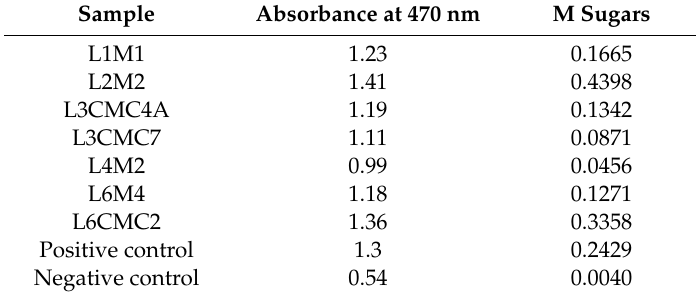
Table 2. Candida xylanilytica strain cellulase test with tetrazolium blue method. Microbes were reared in nutrient broth, then a sample incubated with CMC in a buffer for 13 min, boiled with tetrazolium blue reagent for 5 min to stop the reaction, and the color change measured using a spectrophotometer. By calibrating the machine with known concentrations of glucose, the concentration (M) of reducing sugars can be quantified. The samples are Candida xylanilytica strains from Oryctes rhinoceros larvae. The positive control is Chaetomium globosum . The negative control is sterile nutrient broth.